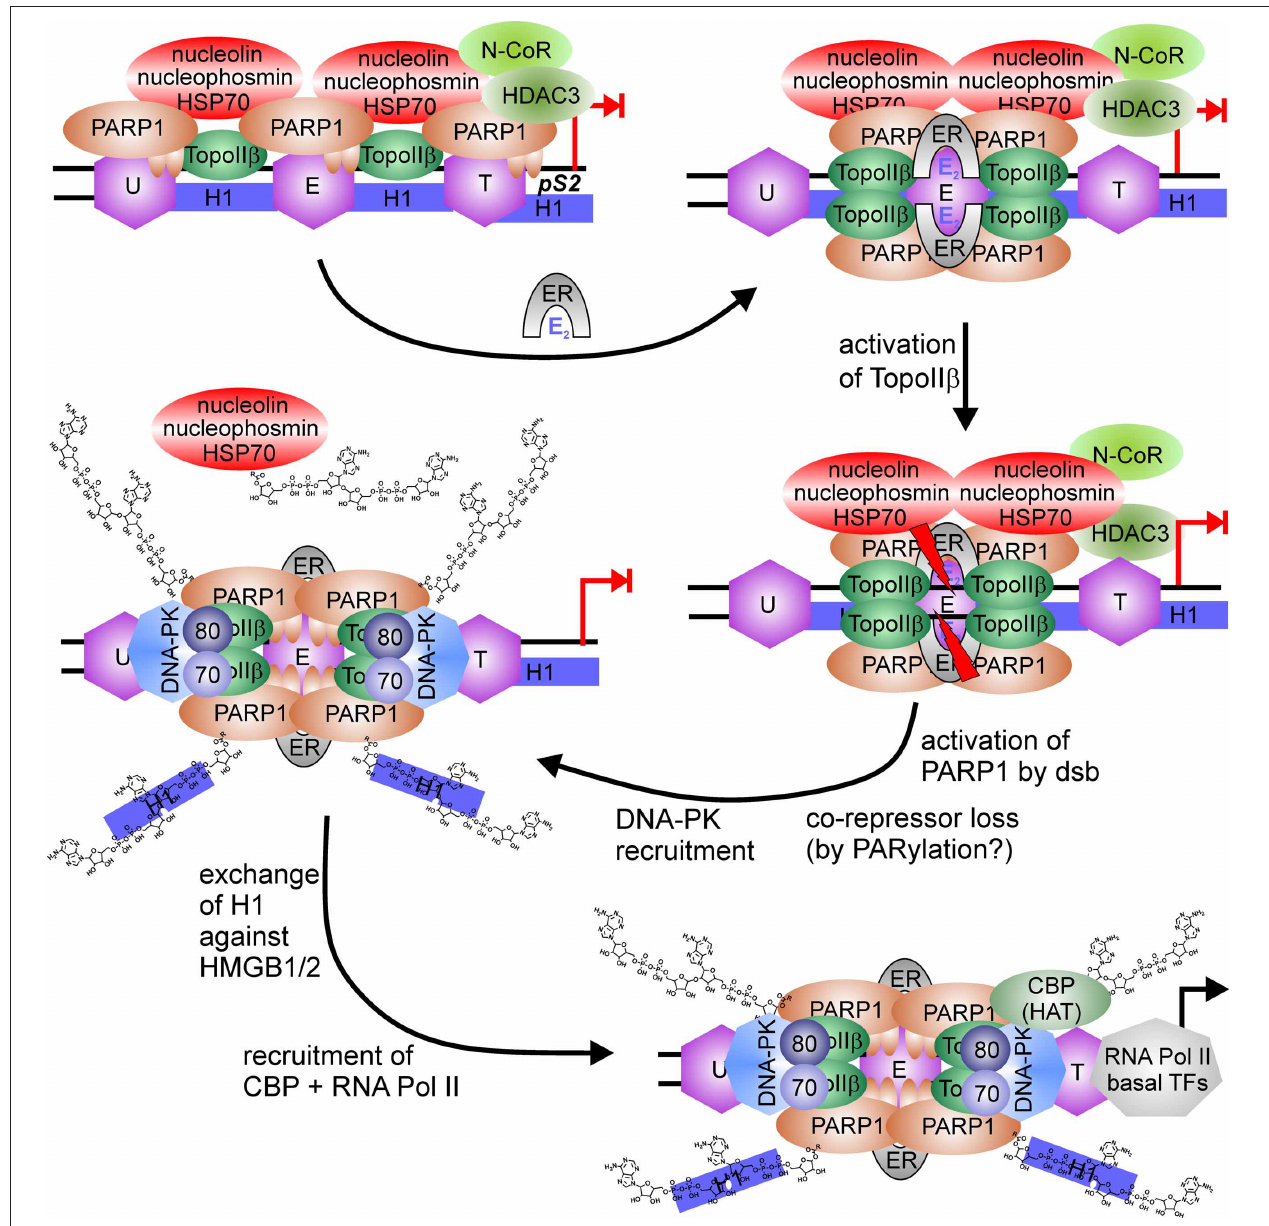
FIGURE 4 | PARP1-switch from repressor to activator of pS2 expression. PARP1 is member of a large co-repressor complex with nucleolin, nucleophosmin, HSP70, TopoII β , PARP1, and N-CoR. 17 β –estradiol (E 2 ) application recruits estrogen-receptor (ER) to the ER responsive element, where the nucleosome (E) is localaized. This induces enrichment of TopoII β and PARP1 at the same site (E) and loss at surrounding nucleosomes located upstream (U) or downstream at the